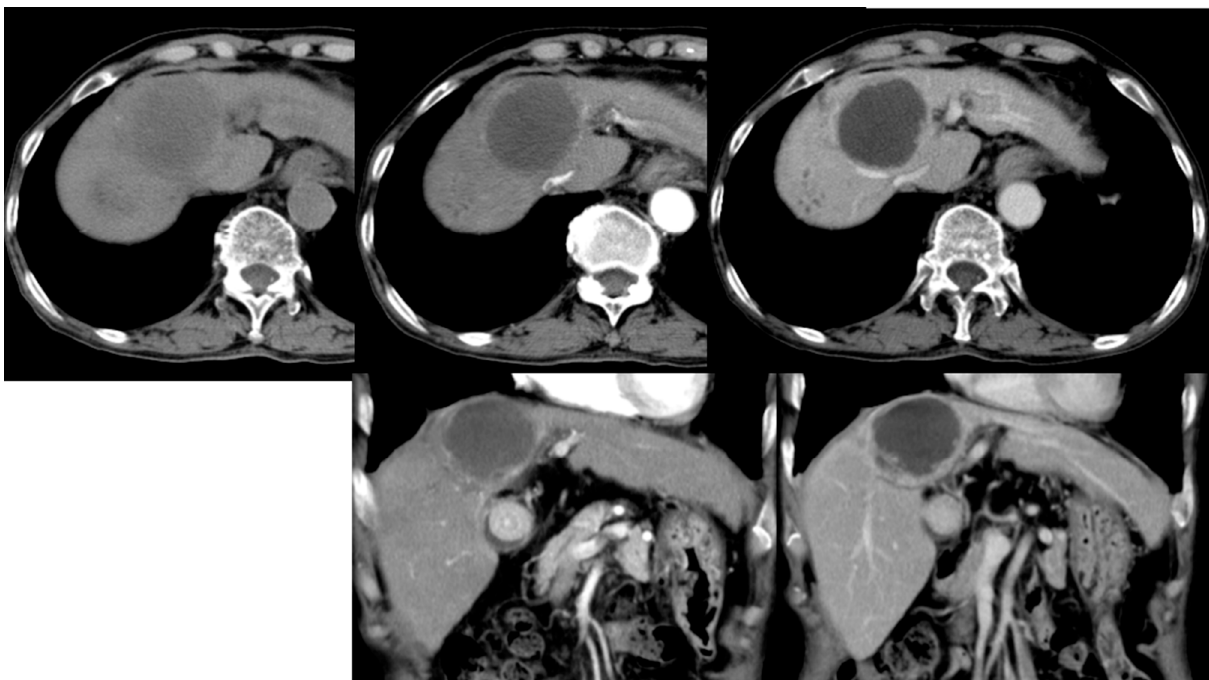
Figure 3. In a follow-up liver dynamic CT after treating with drug-eluting microspheres TACE, the tumor shows almost total necrosis.